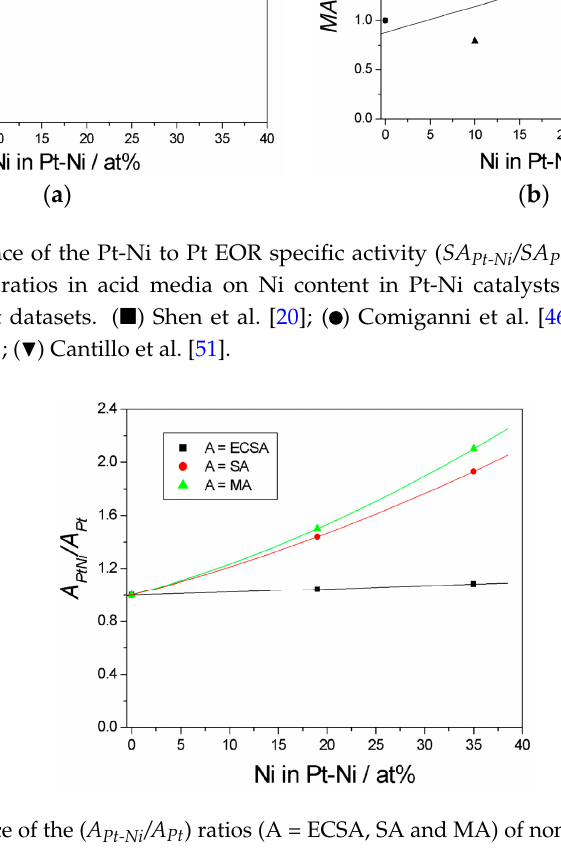
content in the catalysts. Data from Reference [46].